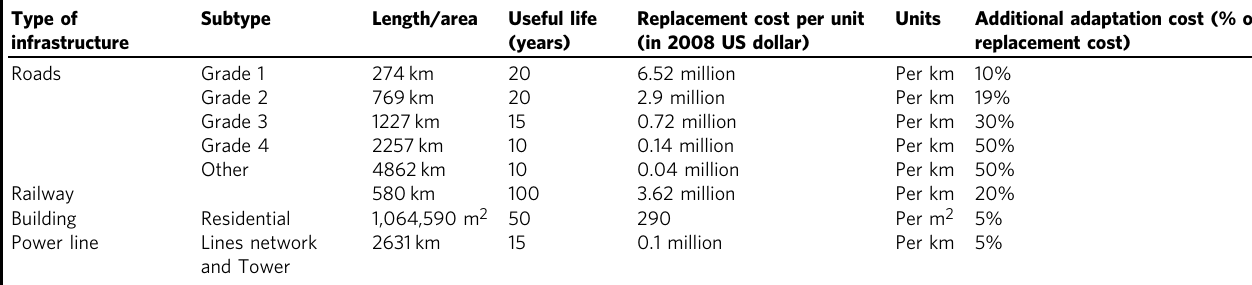
Table 2 The infrastructure database in the permafrost region of the Third